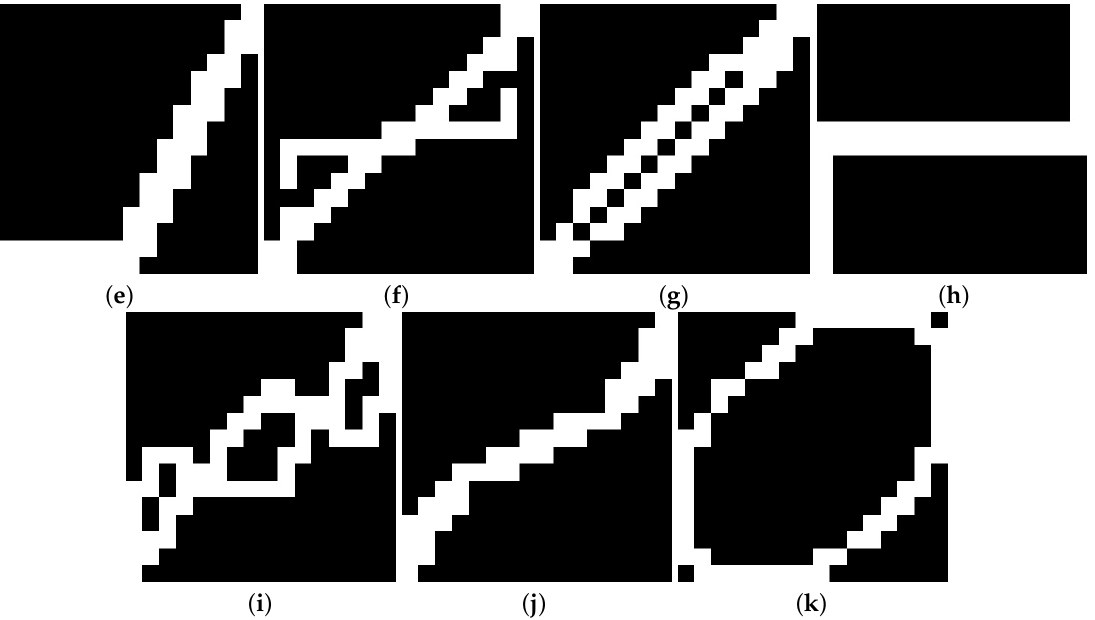
Figure 5. The generated binary images of ( a ) air conditioner, ( b ) compact fluorescent lamp, ( c ) fan, ( d ) fridge, ( e ) hairdryer, ( f ) heater, ( g ) incandescent light bulb, ( h ) laptop, ( i ) microwave, ( j ) vacuum, and ( k ) washing machine for PLAID dataset.